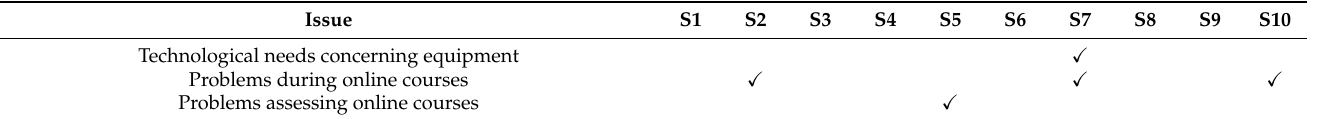
Table 4. First category.